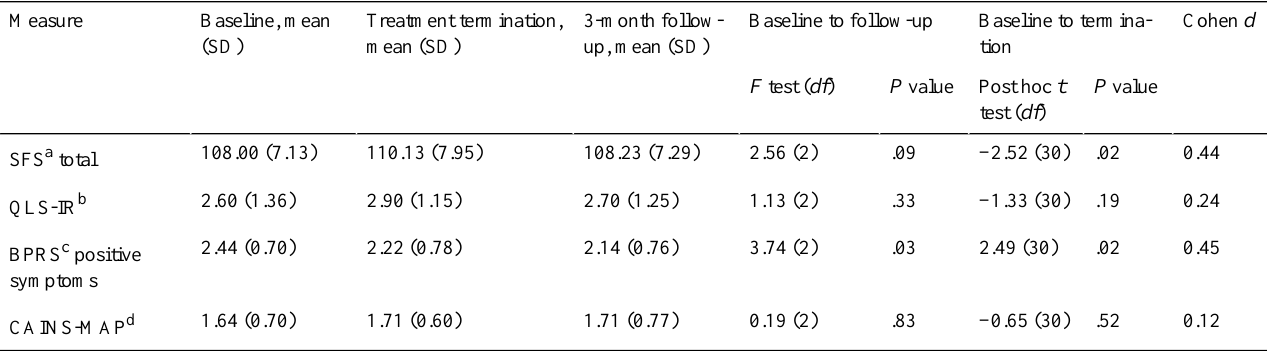
Table 3. Intervention outcomes: social functioning, positive symptoms, and motivation and pleasure negative symptoms.